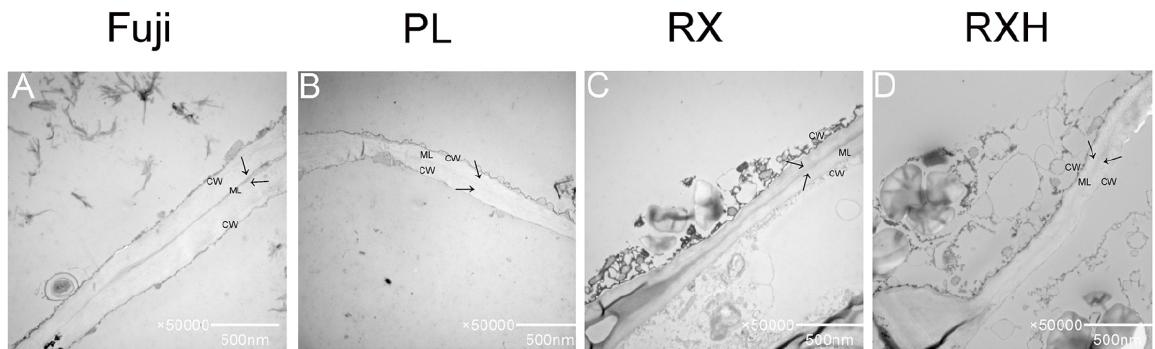
Figure 6. Transmission electron microscope of different cultivars during the fruit ripening stage. ( A ) Fuji; ( B ) Pink Lady; ( C ) Ruixue; ( D ) Ruixianghong. CW: cell wall, ML: middle lamella. ( A – D ): 50,000 × ; size bars, 500 nm.